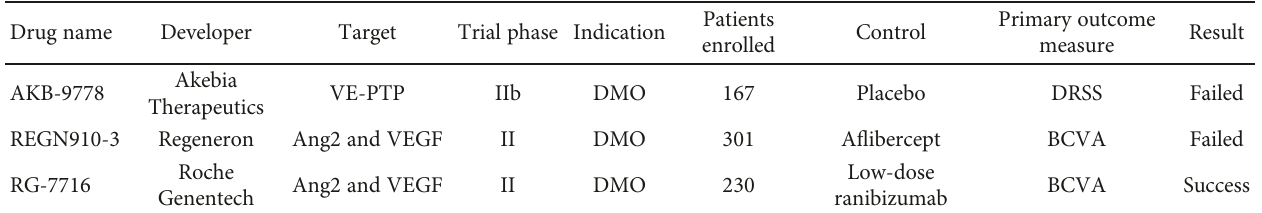
Table 2: Overview of agents targeting the Ang/Tie2 pathway that are currently in clinical